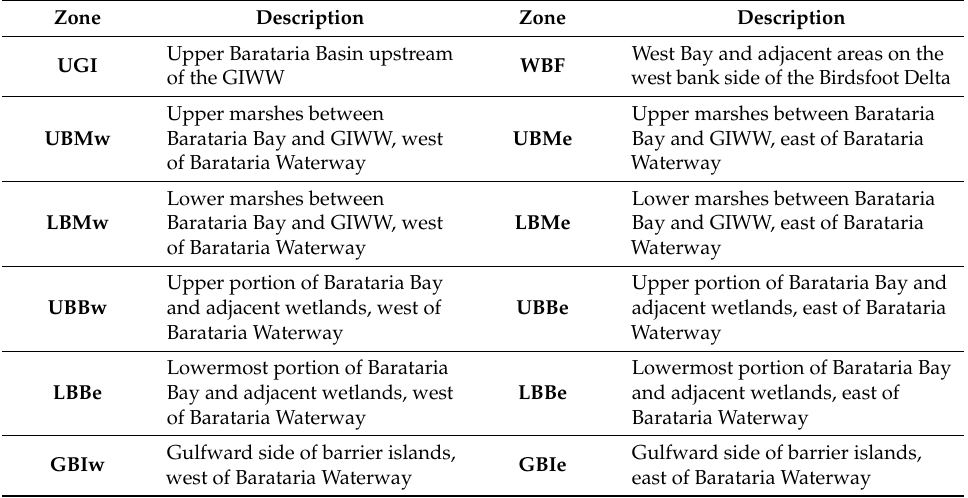
Table 1. Description of twelve zones developed for spatially averaged salinity